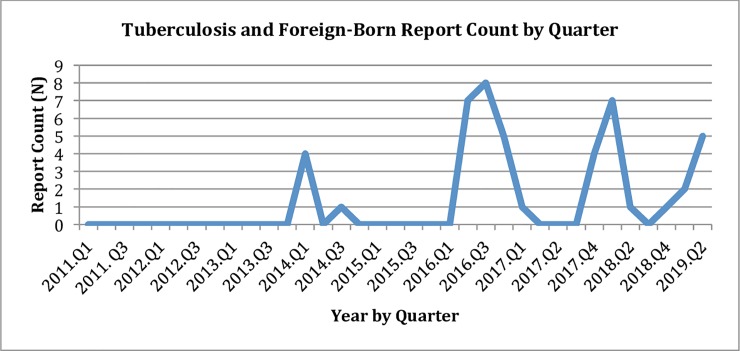
Tuberculosis and foreign-born persons report count by quarter.